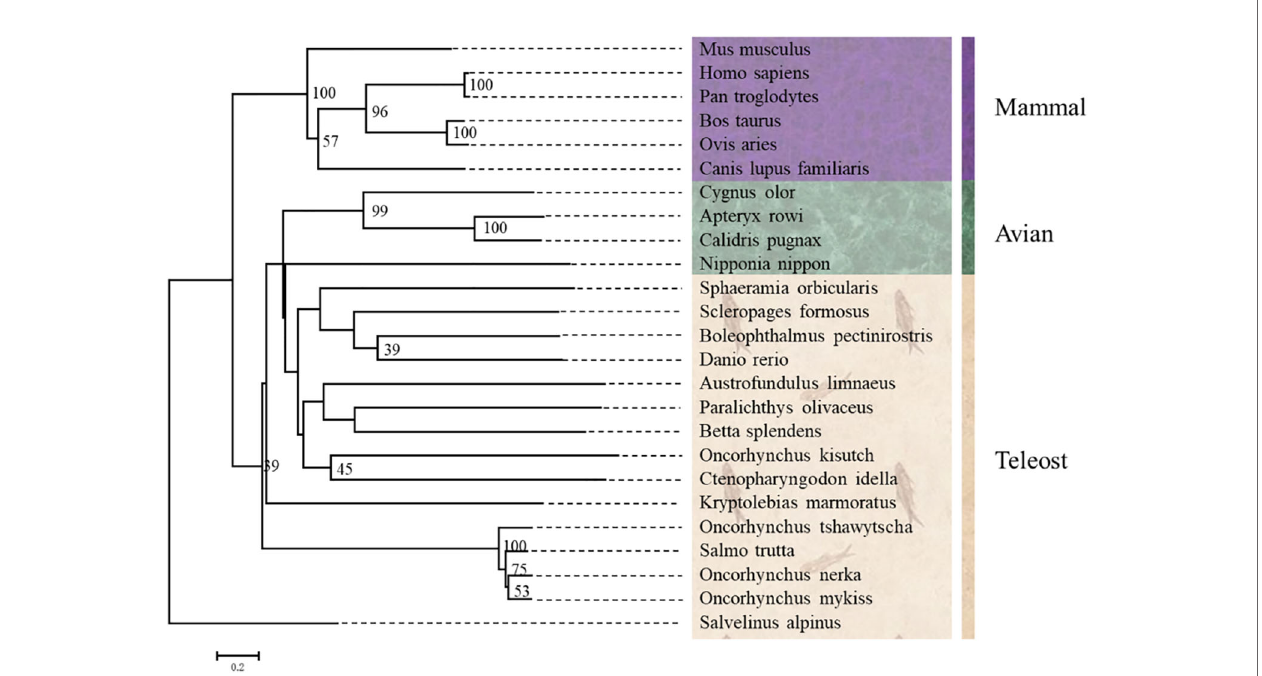
FIGURE 2 | Phylogenetic trees of ICAM-1 gene from Oncorhynchus mykiss and other vertebrates were constructed using MEGA7.0 with the neighboring- joining (NJ) method.